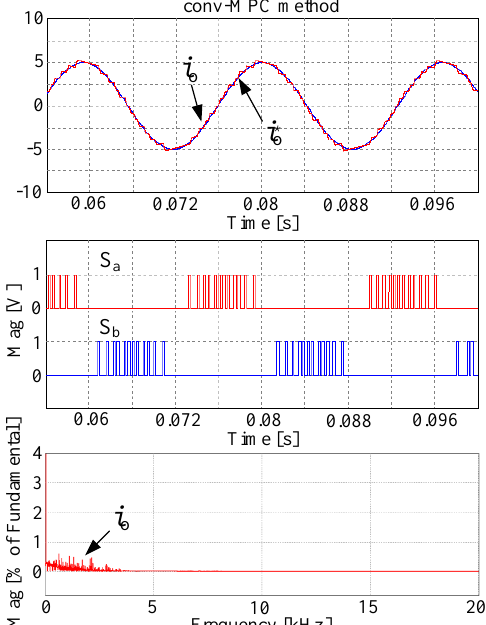
Figure 2. Simulation result of the output current ( i o ), reference current ( i o * ), switch state ( S a , S b ), and fast Fourier transform (FFT) analysis of output current ( i o ) by the conventional model predictive control (conv-MPC) method ( R = 1.5 , L = 24 mH, and T s = 200 μs).